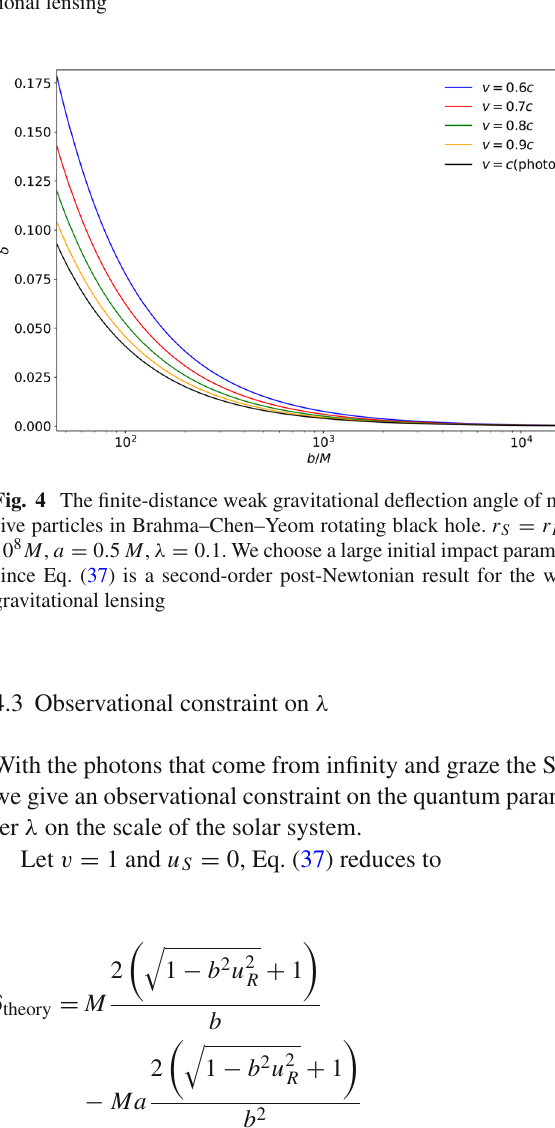
Fig. 3 The finite-distance weak gravitational deflection angle of mas- sive particles in Brahma–Chen–Yeom rotating black hole. r S = r R = 10 8 M , v = 0 . 7 c . We choose a large initial impact parameter since Eq. (37) is a second-order post-Newtonian result for the weak gravita- tional lensing